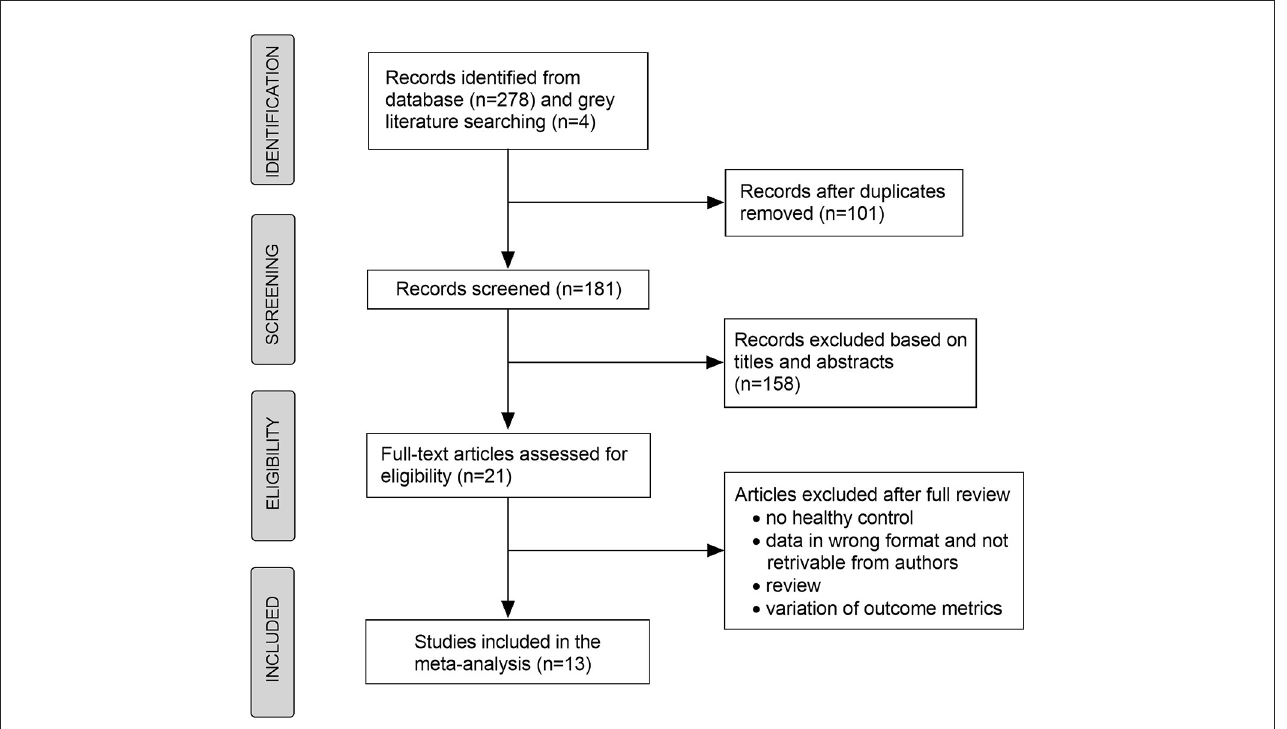
FIGURE1 Flow chart depicting the selection of the studies included in the